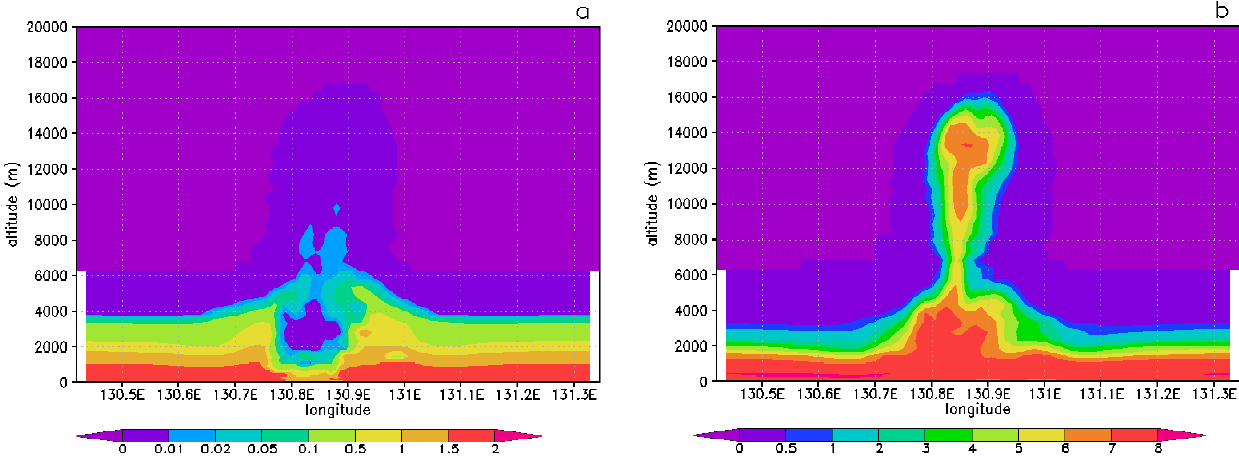
+30min of the BrWMR for a) 0